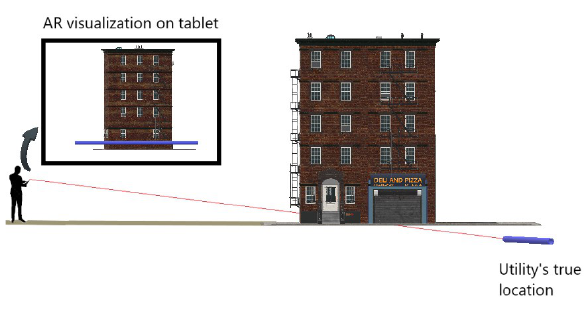
Figure 2. Underground utility visualization in